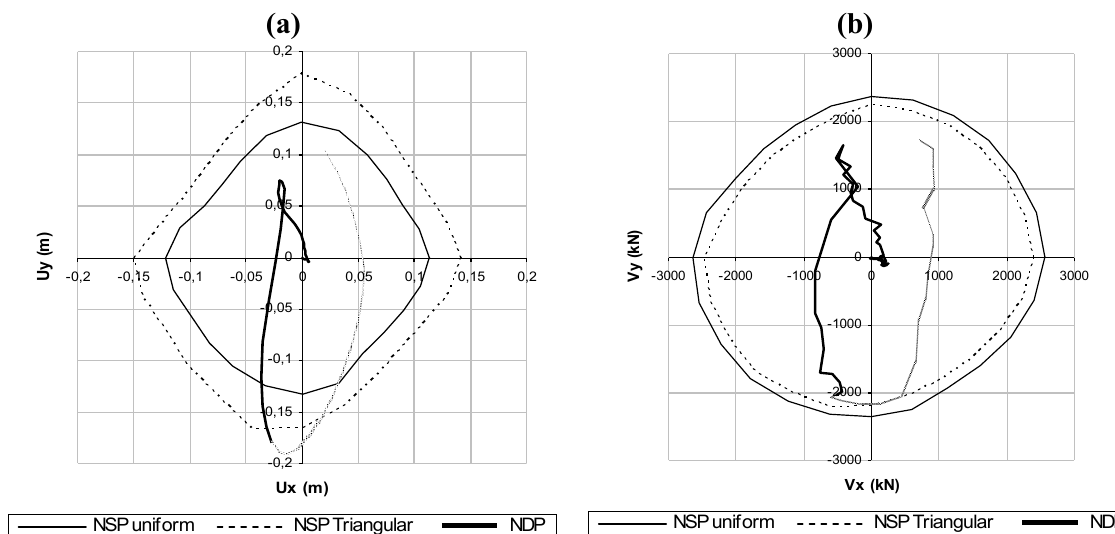
Figure 3. ( a ) Comparison between capacity domains and NDP-Collapse amplification factor 0.40-In plan orientation of benchmark structure 0°; ( b ) Comparison between capacity domains and NDP-Collapse amplification factor 0.40-In plan orientation of benchmark structure